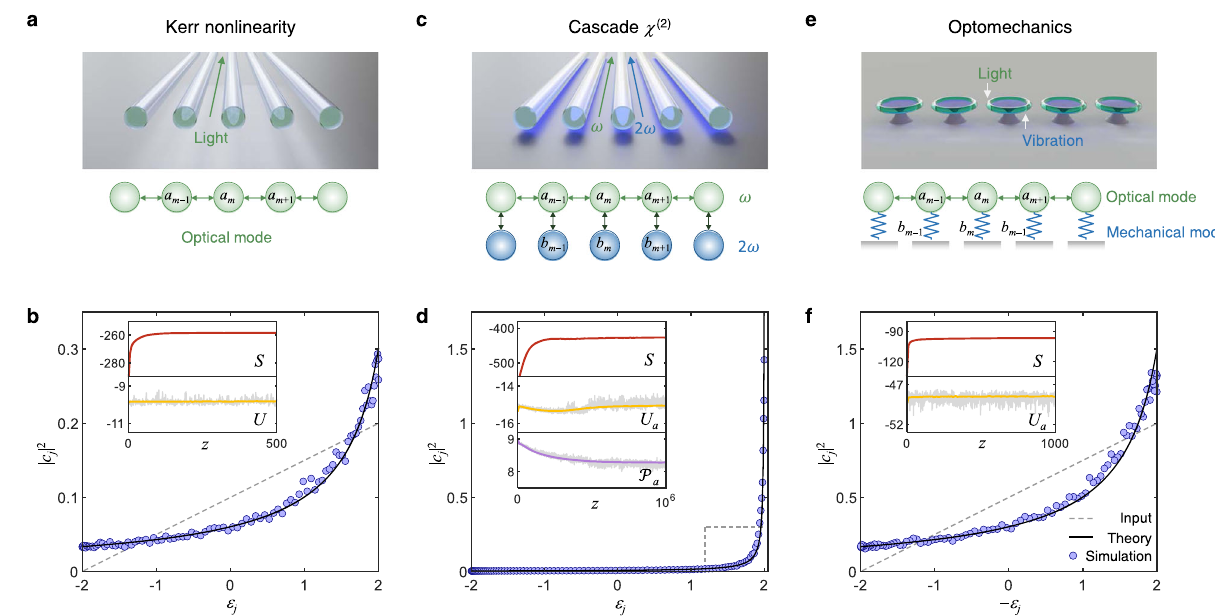
displaya monotonicincrease in entropy S aswellasthe invariants ofthe motion U and P . Note that in all cases, numerical simulations are performed over ensemble averages. The thermal fl uctuations of quasi-invariants (when applicable) are indi- cated by gray lines, depicting the instantaneous values of U and P around their mean values.In allcases, thenonlineararrayhas M =100sites and thedashed lines represent the initial occupancies for the linear optical